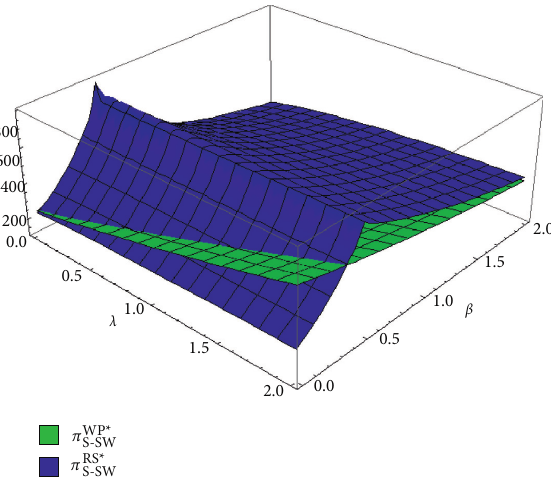
Figure 11: Effect of λ and β on the supplier’s expected profit.